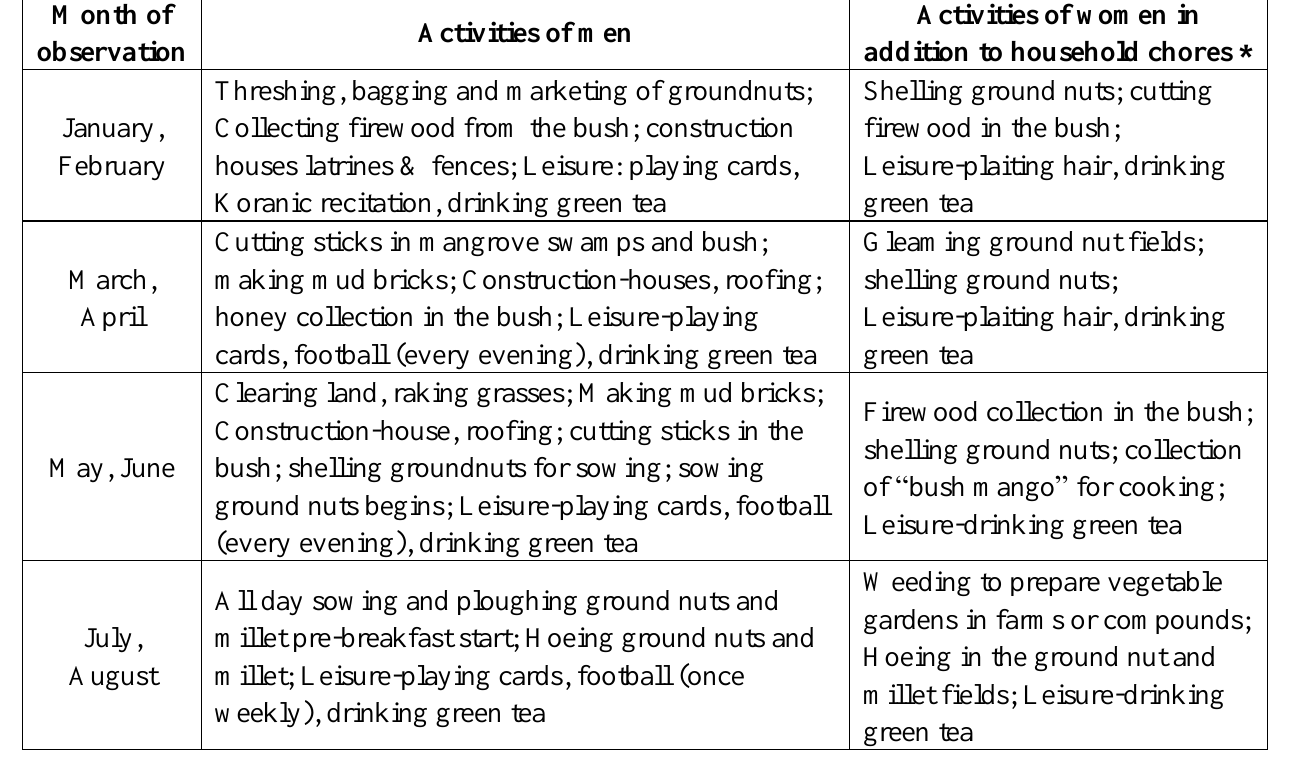
Table 7. Divisions of labour by gender during farming and non-farming